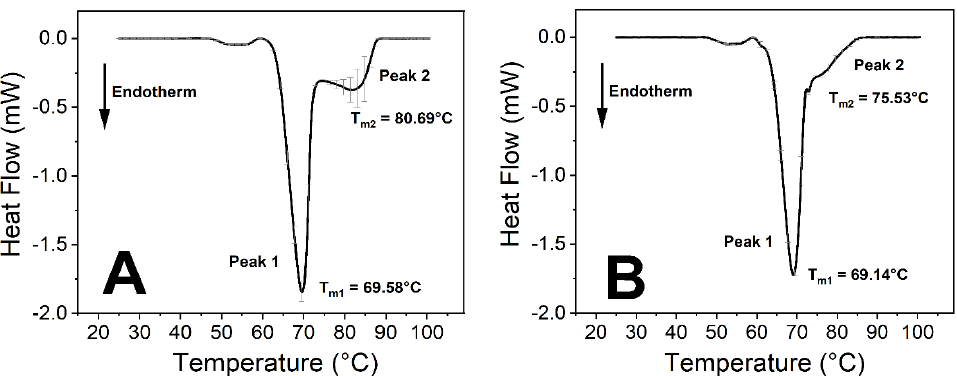
Figure 1. The thermal analysis of untreated and SARS-CoV-2-treated anticoagulated human whole blood samples. ( A ) Control: 25 h of incubation at 37 °C. ( B ) Treated with SARS-CoV-2 and incubated for 25 h at 37 °C. The measurements were performed at least four times independently ( n ≥ 4) and the results are presented as mean ± SD.